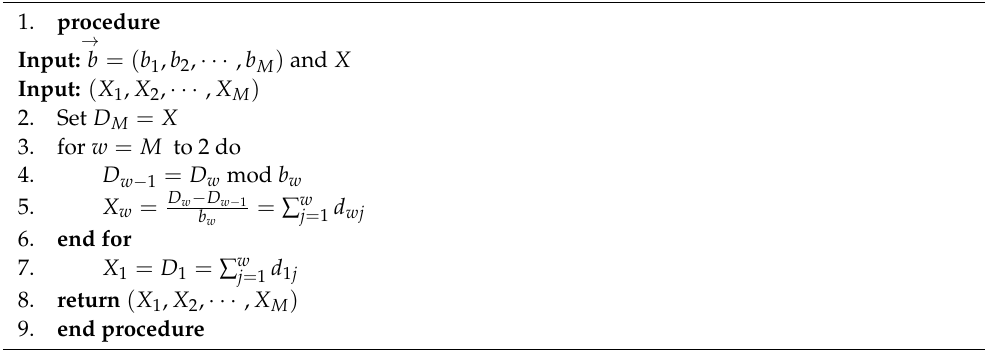
Algorithm 1. Recover aggregated reports for each aggregation